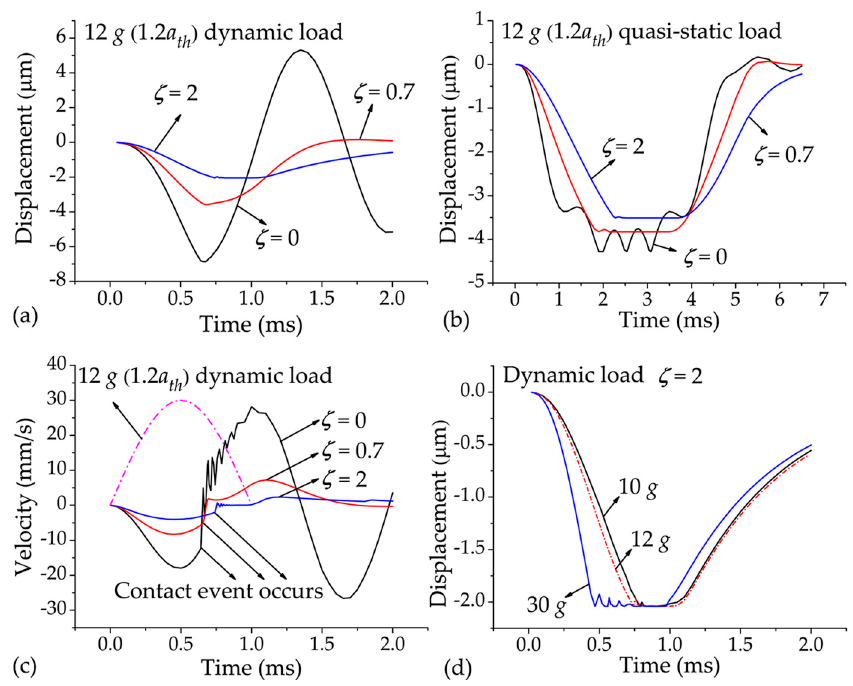
Figure 3. ( a , b ) Displacement responses of the switch ( ζ = 0, 0.7, and 2) under the accelerations of ( a ) 12 g (1.2 a th ) dynamic load and ( b ) 12 g (1.2 a th ) quasi-static load; ( c ) Velocity responses of the switch ( ζ = 0, 0.7, and 2) under 12 g (1.2 a th ) dynamic load; ( d ) Displacement responses of the switch ( ζ = 2) under 10 g, 12 g, and 30 g dynamic loads.